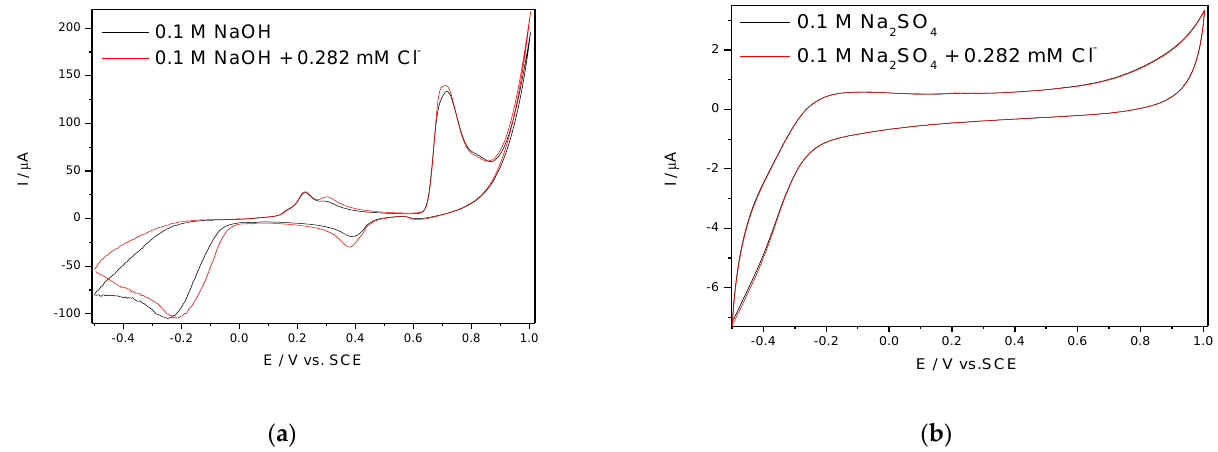
Figure 6. CVs recorded at the scan rate of 0.050 V·s − 1 in the presence of 0.282 mM Cl − in the supporting electrolyte: 0.1M NaOH ( a ) and 0.1M Na 2 SO 4 ( b ).